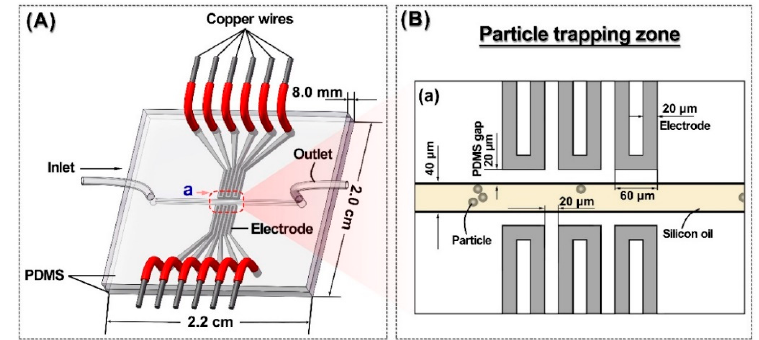
Figure 1. ( A ) Schematic view of a polydimethylsiloxane (PDMS) microfluidic chip; ( B ) Zoom-in schematic of (a). The target particle was trapped under the control of three pairs of liquid metal electrodes.